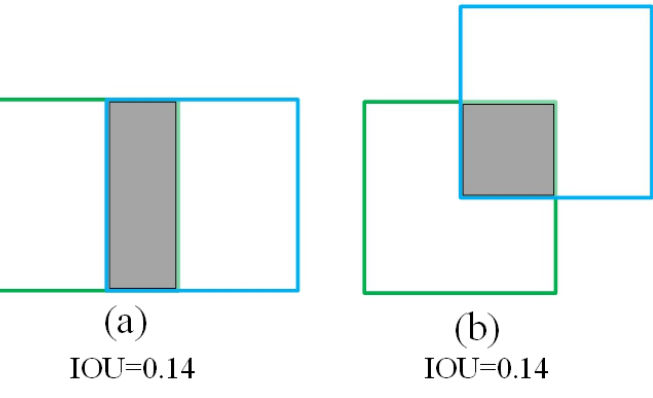
Figure 4. Coincident position relationship between detection frame and prediction frame. ( a ) Hori- zontal overlap. ( b ) Cross overlap.